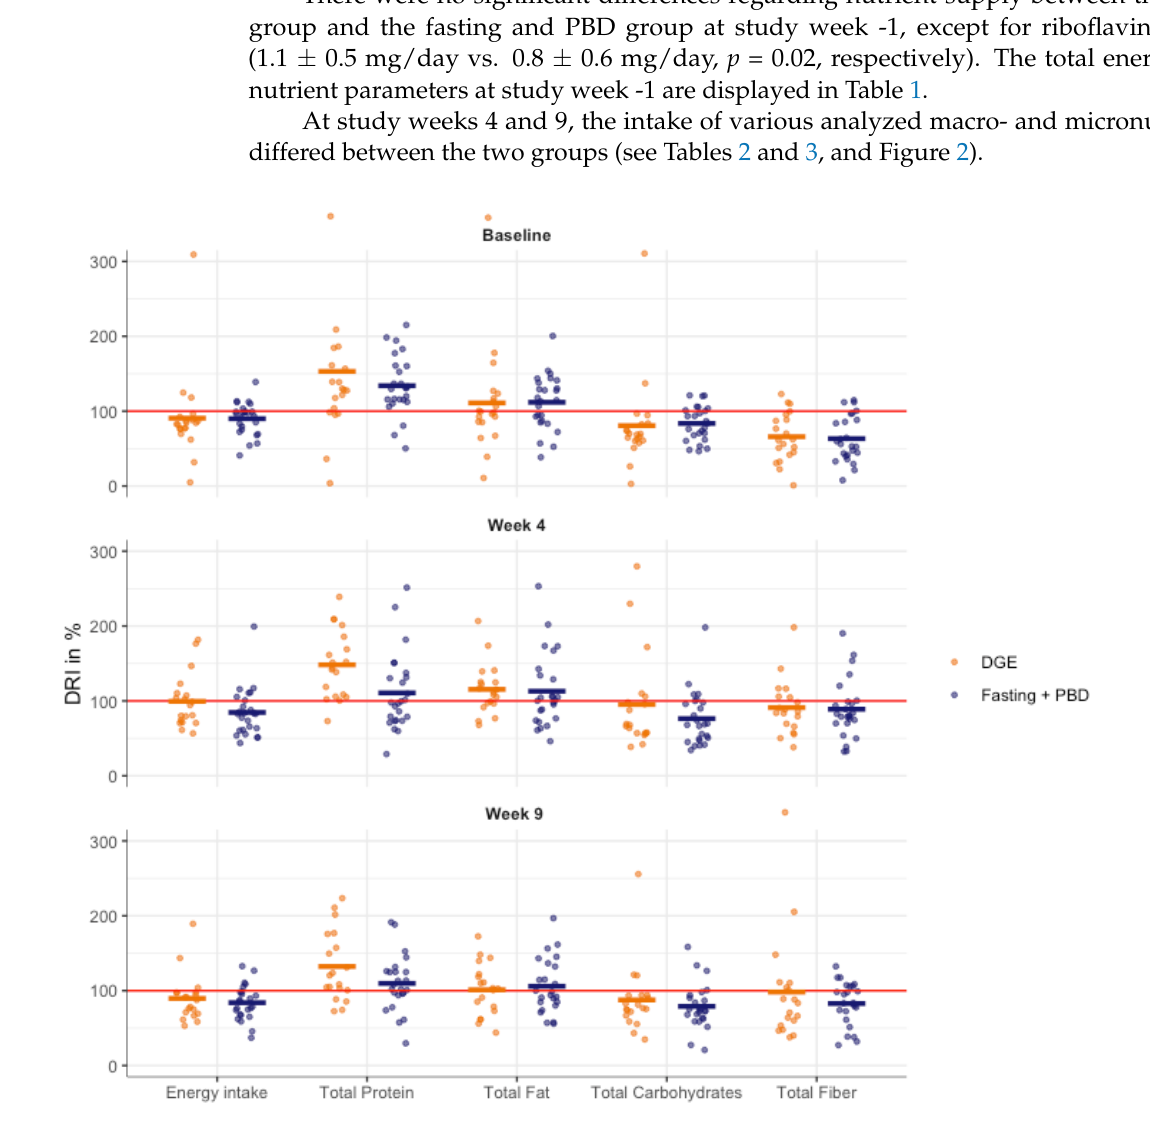
Figure 2. Dietary intake displayed as percentage of adequate nutrient intake according to the D-A-CH reference values at study weeks -1, 4 and 9: energy intake, total protein, fat, carbohydrate and fiber intake. DGE, German Nutrition Society; DRI, dietary recommended intake; PBD, plant-based diet.